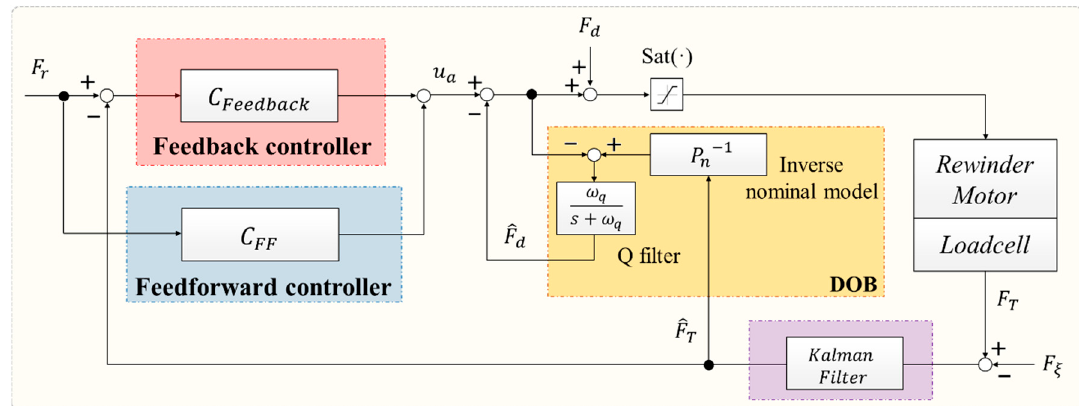
Figure 5. Structure of the proposed controller for R2R system.